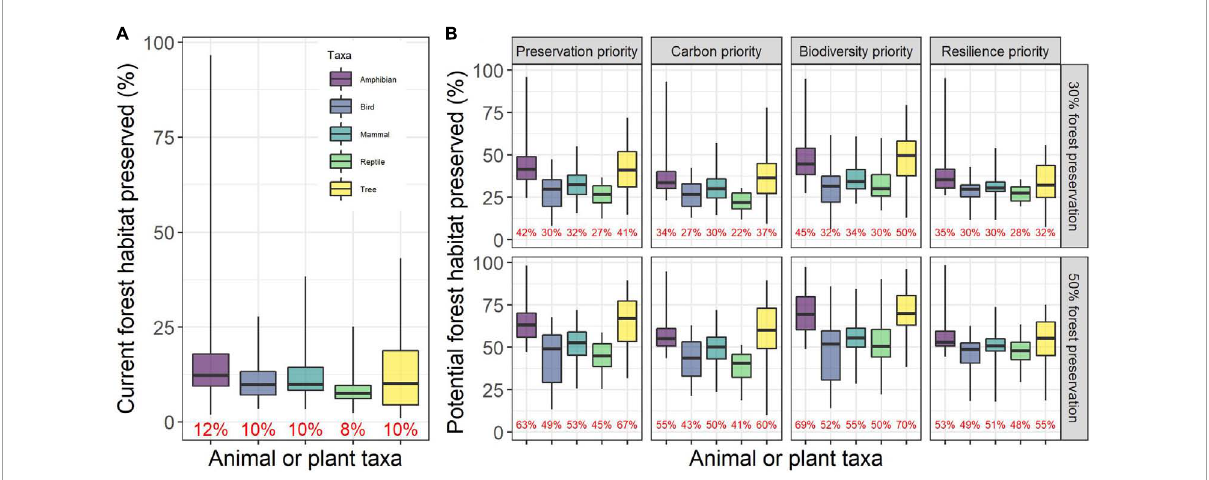
FIGURE7 Current and potential protection of animal taxa and tree species forest habitat across Oregon. The percentage of each species’ forest habitat that (A) is currently protected and (B) would be protected by meeting preservation targets based on each priority. The median percentage of current and potential protected species habitat is provided for each taxon (red text). Boxplots depict medians (intra-box lines), 25th–75th percentiles (box edges), and 5th to 95th percentiles (whiskers). Animal and tree species habitat data were from the USGS GAP (2018) and Landscape Ecology Modeling Mapping and Analysis (Lemma) Team (2020),